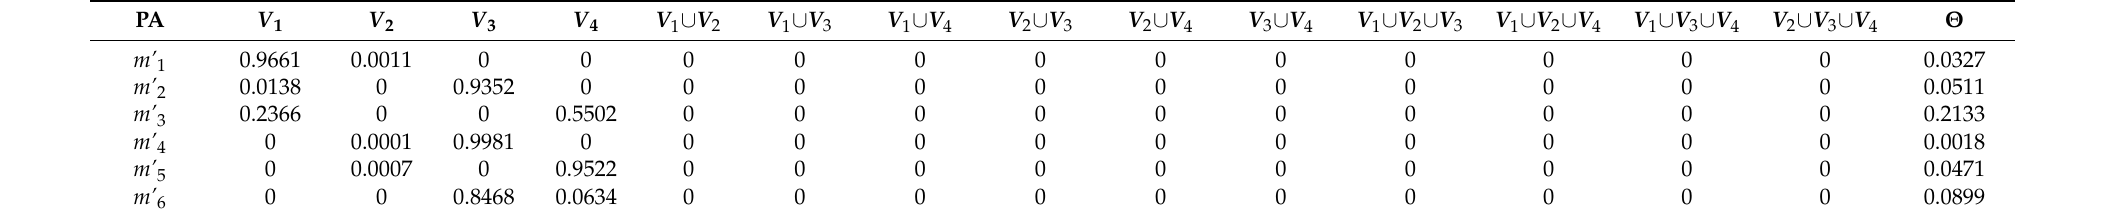
Table 17. The result of first-level combination for an image of a transverse crack based on OAO classifiers.